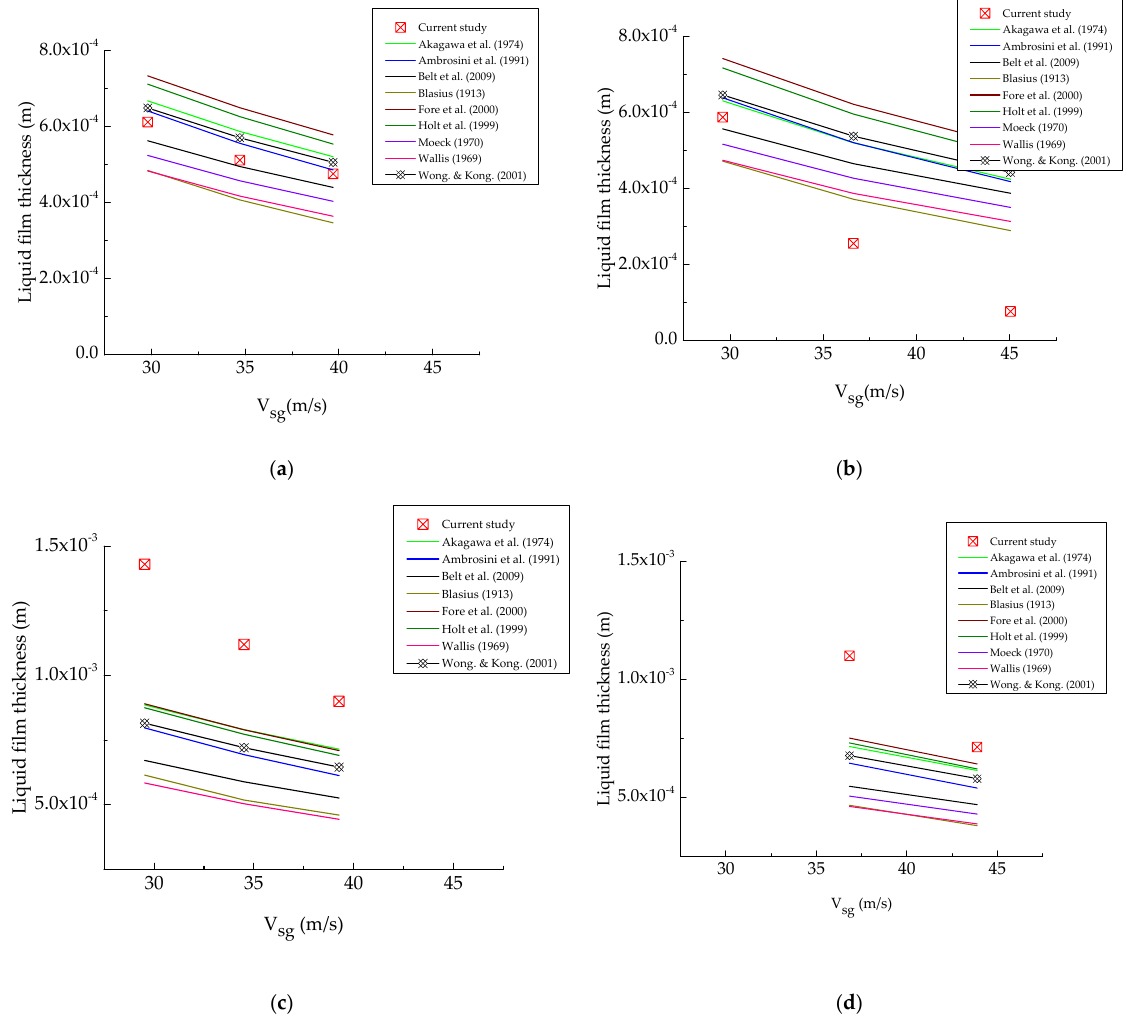
Figure 7. Comparison of experimental liquid film thickness with predictions of two-fluid model using selected f i correlations at 100 ( a , b ) and 200 ( c , d ) mPa s.